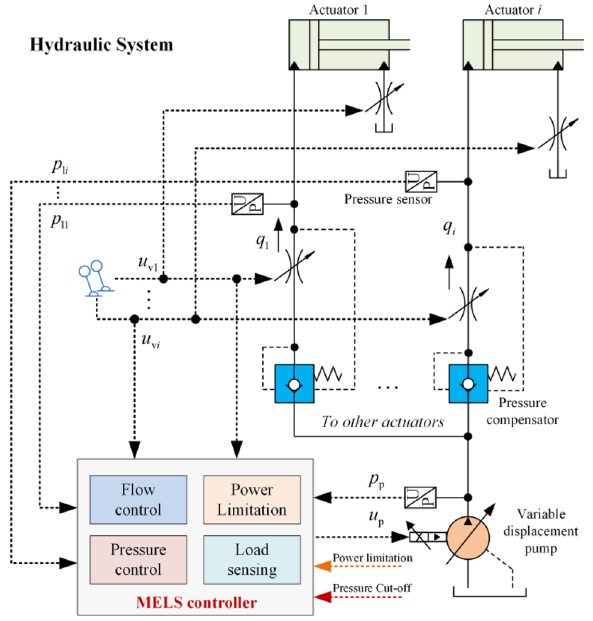
Figure 1 Hydraulic system with primary pressure